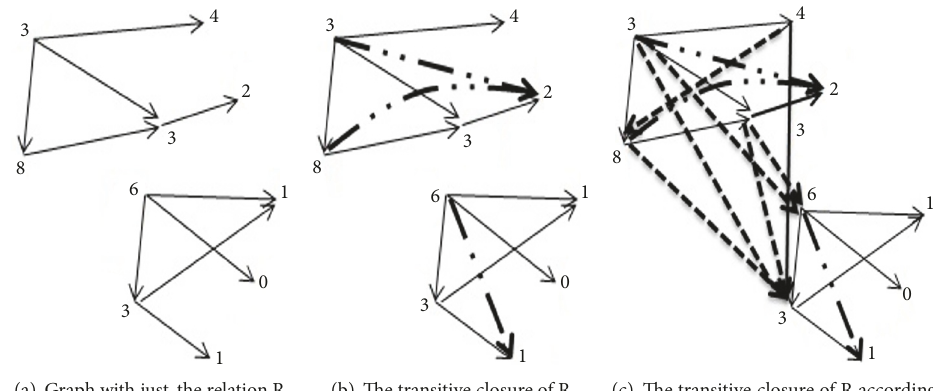
Figure 1: Illustration of the closure